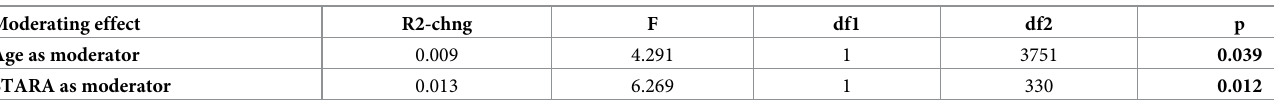
Table 4. Results of moderation